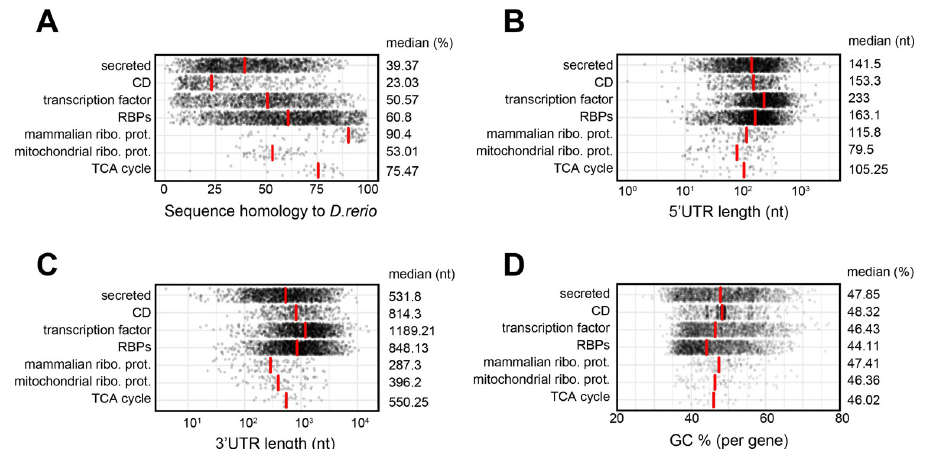
Fig 3. Distinct gene characteristics are associated with gene functions. ( A-D ) Relation between gene classes (Fig 2) and sequence homology of human genes with Zebrafish ( D . rerio ) (A), the length of the 5’UTR (B) and 3’UTR (C), and the GC content (D). Red bars indicate the median values per gene class, which are also indicated numerically at each respective graph. nt: